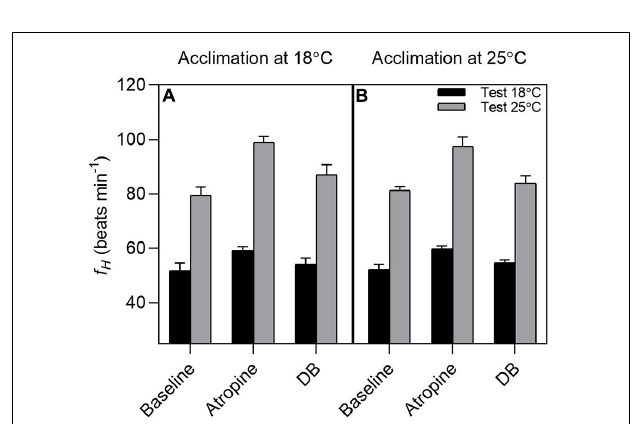
FIGURE 5 | Effect of pharmacological blockade on heart rate in tadpoles of Bokermannohyla ibitiguara . The effects of pharmacological blockade (atropine alone and double blockade = atropine + sotalol) on heart rate ( f H ) in tadpoles acclimated at 18 ◦ C ( N = 8) and tadpoles acclimated at 25 ◦ C ( N = 7) at different experimental test temperatures (18 and 25 ◦ C). Regardless of the treatment treatment used, the f H was significantly altered by temperature of 25 ◦ C ( P < 0.001). Data are shown as means ±